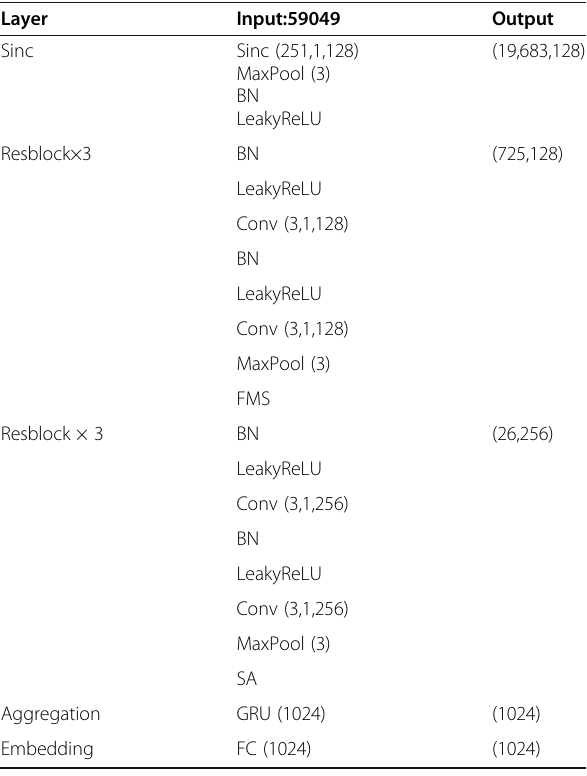
Table 1 The structure of RawNet-SA